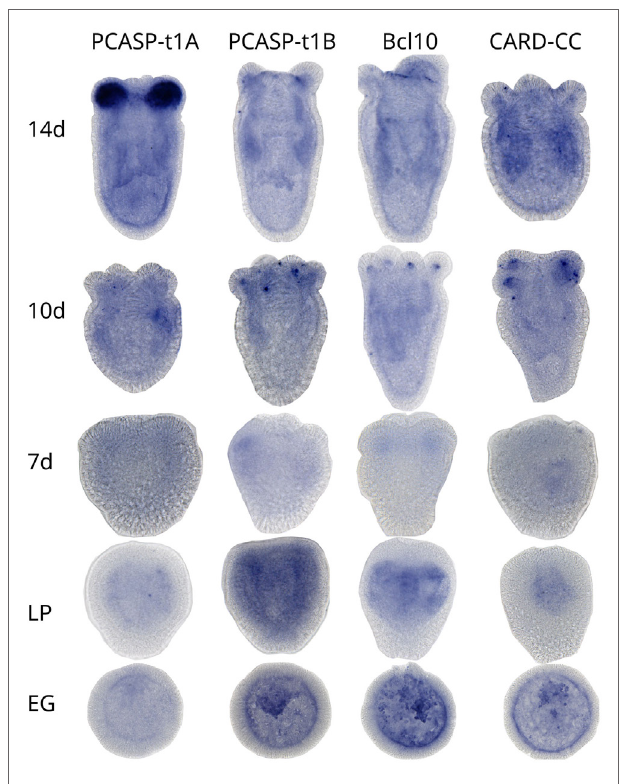
FigUre 7 | The CBM complex components show overlapping expression in Nematostella vectensis (Nvn). Developing Nvn embryos were stained for the indicated genes via in situ hybridization at 11 different developmental stages, from the unfertilized egg stage to 14 days post fertilization. Representative pictures from 14 days (14d), 10 days (10d), 7 days (7d), late planula (LP), and early gastrula (EG) stages for all 4 CBM complex genes analyzed are shown.